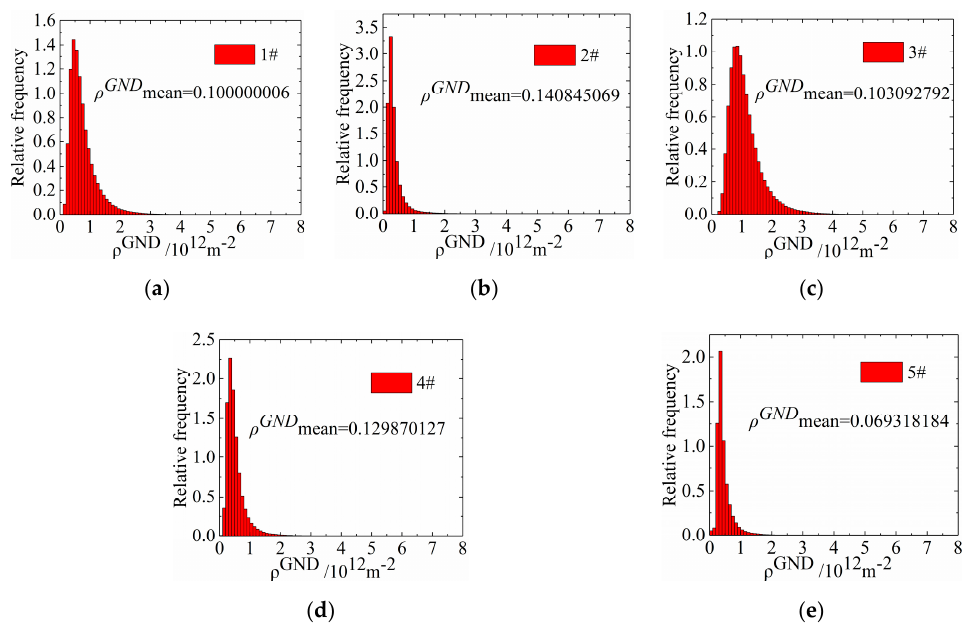
Figure 12. Specimen ρ GND distribution for different cryogenic parameters. ( a ) Specimen #1. ( b ) Specimen #2. ( c ) Specimen #3. ( d ) Specimen #4. ( e ) Specimen #5.